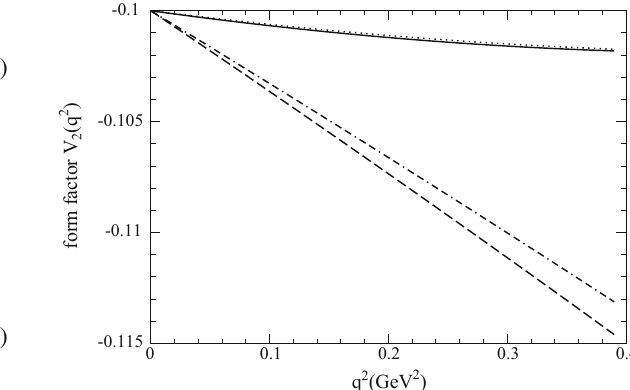
Fig. 1 Comparison of the different forms for the form factor V 2 ( q 2 ) corresponding to the values F ( 0 ) = − 0 . 10 , a = 0 . 26 , b = 0 . 090. The solid ( dashed ) line corresponds to Eq. (8) (Eq. (9)), while the dotted ( dot-double-dashed ) line denotes Eq. (8) (Eq. (9)) with m D replaced by m D